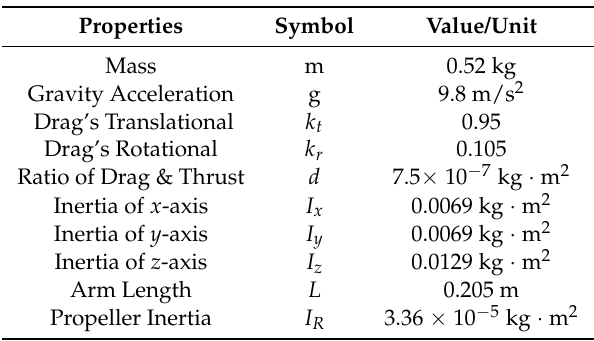
Table 1. The quadrotor model